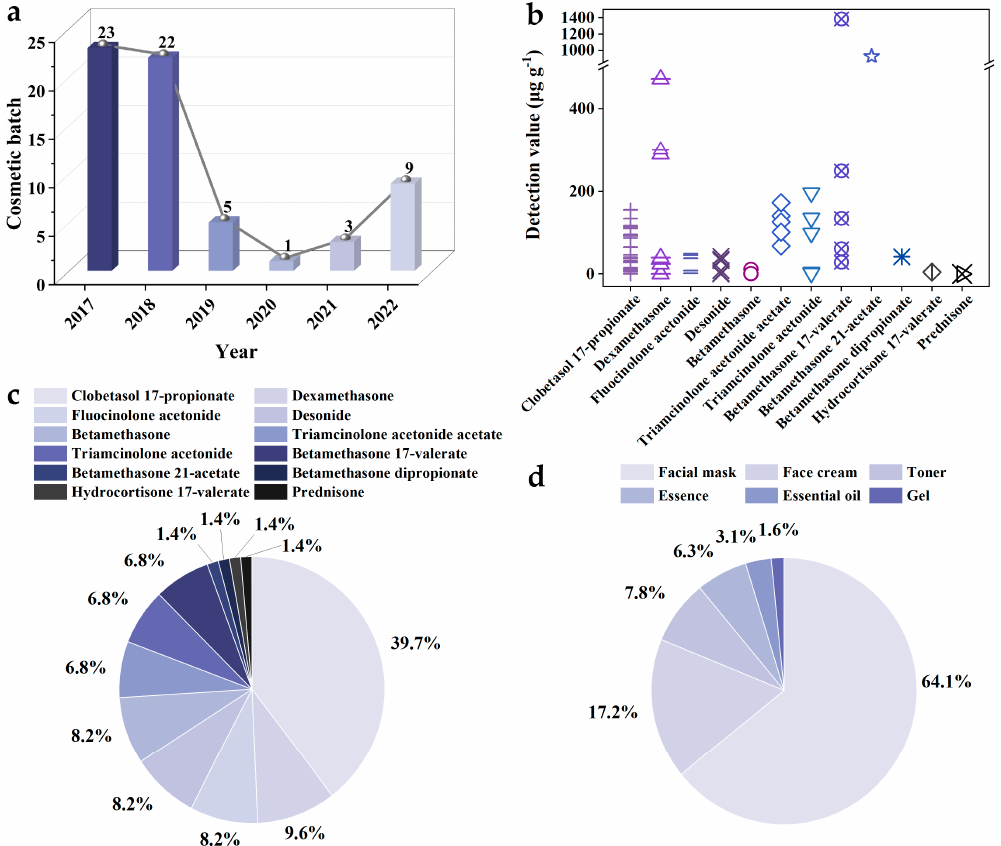
Figure 2. ( a ) The unqualified cosmetic batches containing hormones and ( b ) their detection values in China in recent six years (2017–2022). ( c ). Hormone types, frequency, and ( d ) cosmetic types in the above unqualified cosmetic batches.